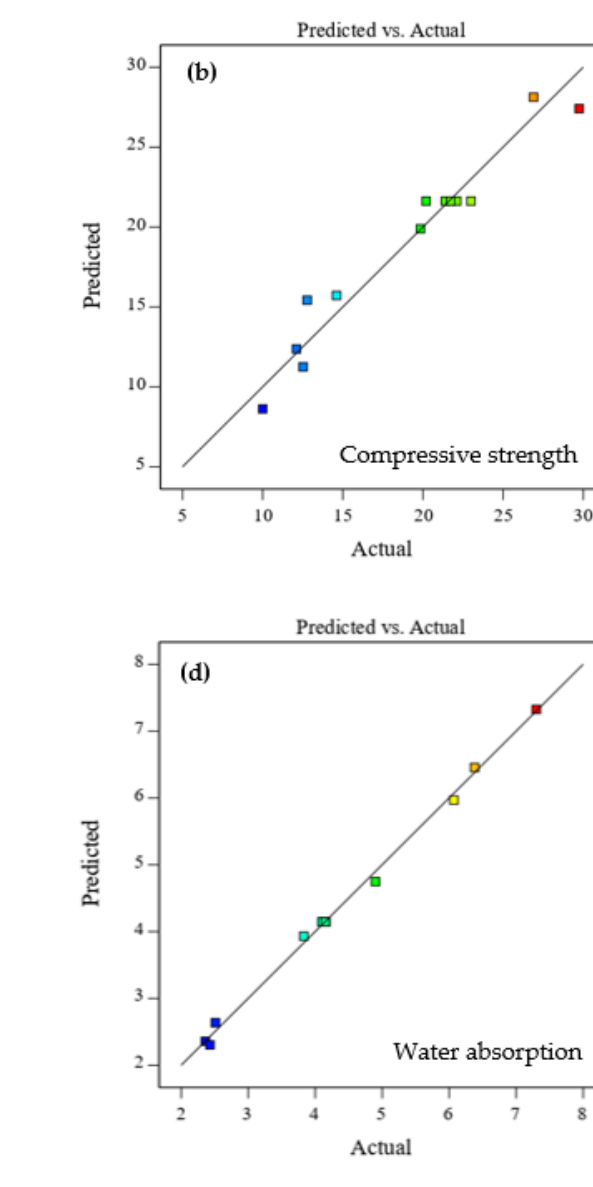
Figure 12. Predicted vs. actual plots for ( a ) flow, ( b ) compressive strength, ( c ) flexural strength, and ( d ) water absorption.